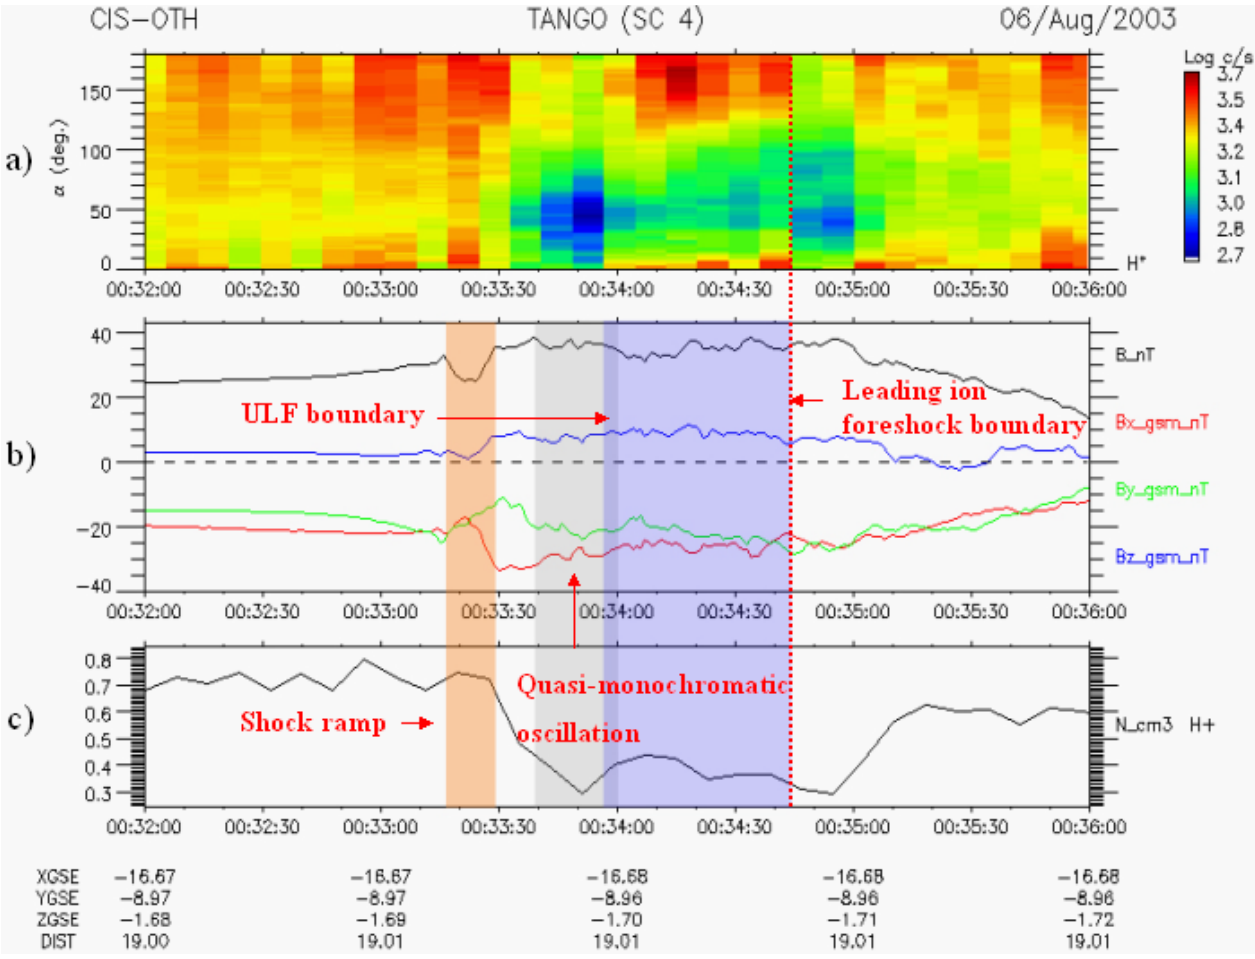
Fig. 6. A snapshot of the magnetic field measurements with 1s resolution and the proton density in the cavity. The red, gray and blue shadows denote respectively the time intervals of the shock ramp, ULF waves, and the backstreaming field-aligned